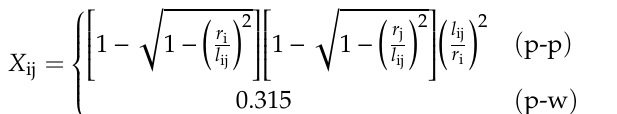
( b ) Figure 2. Schematic of thermal resistance network: ( a ) the case for particle–particle; ( b ) the case for particle–wall ( R 1 : thermal conduction resistance inside particles; R 2 : physical contact thermal conduction resistance; R 3 : thermal conduction resistance through gas film; R 4 : thermal radiation resistance; “G-C” means contact only with gas film; “P–C” means physical contact). total / Q t T R = Δ Δ